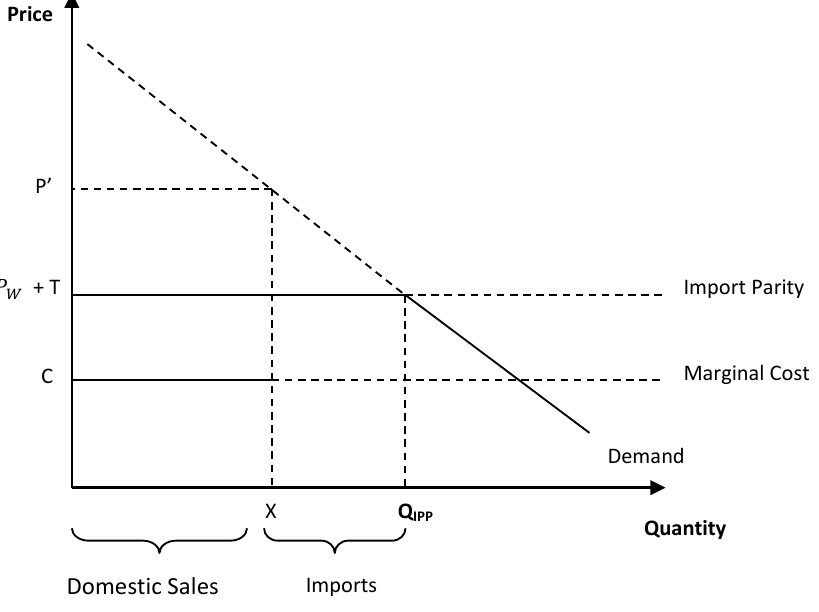
FIGURE 1: IPP with excess demand and perfect competition